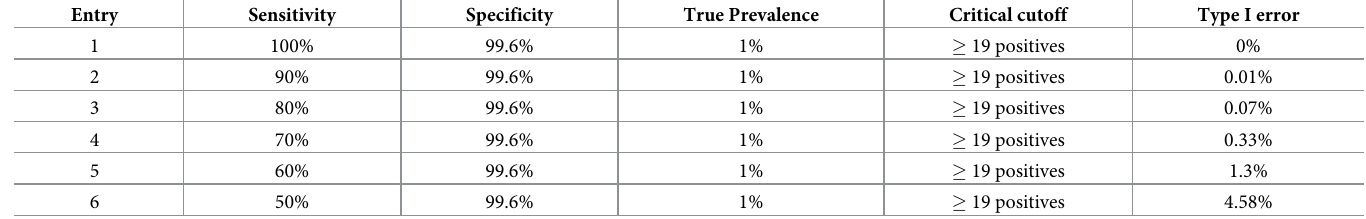
Table 6. Effect of sensitivity on the Type I error of a 30-cluster survey involving 3000 children, where treatment decisions are based on the average prevalence of the entire survey area. A specificity of 99.8% was assumed. The critical cutoff was � 19 positive tests. The calculations were made for a true prevalence of 1%. At least 50% sen- sitivity is required to have a Type I error of <